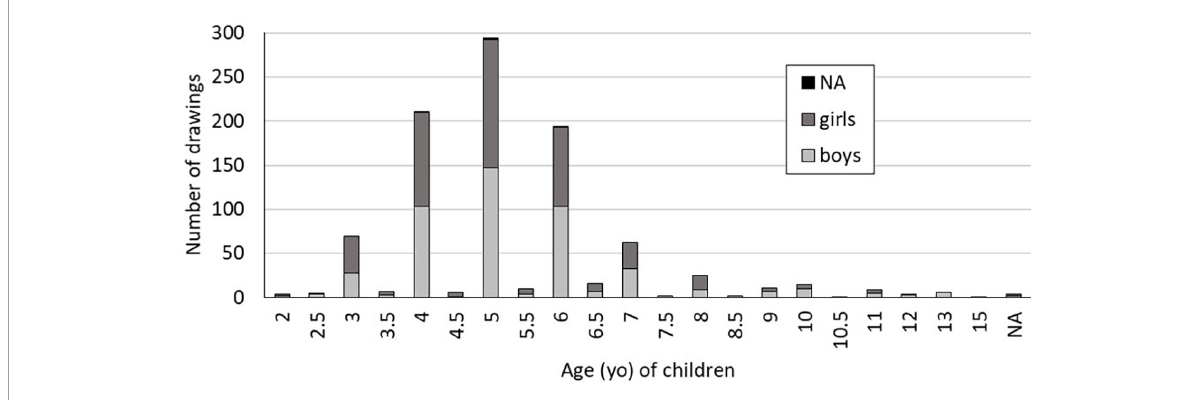
FIGURE1 Numbers of drawings according the age and gender of children.